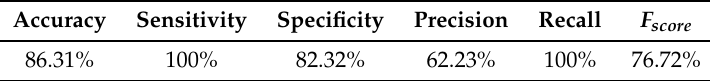
Table 9. Performance measures (Section